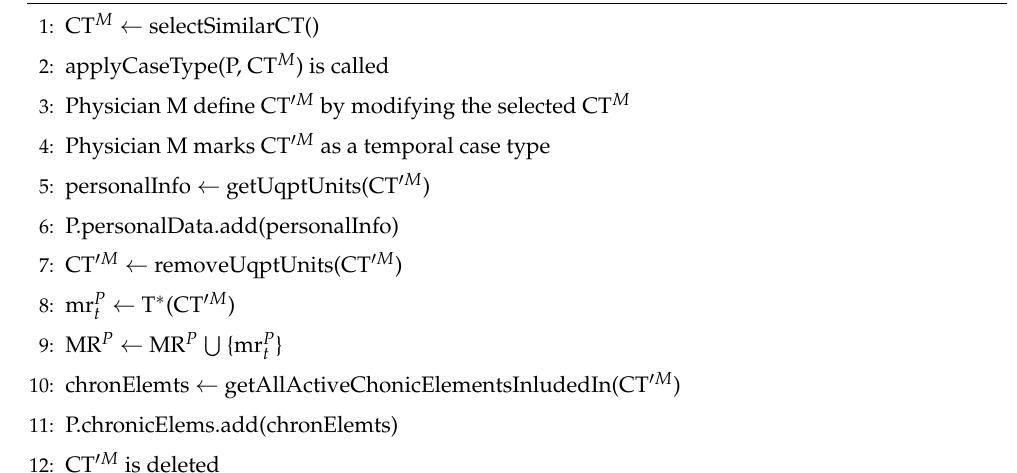
Algorithm 7 Temporal case type flow for the attention of patient